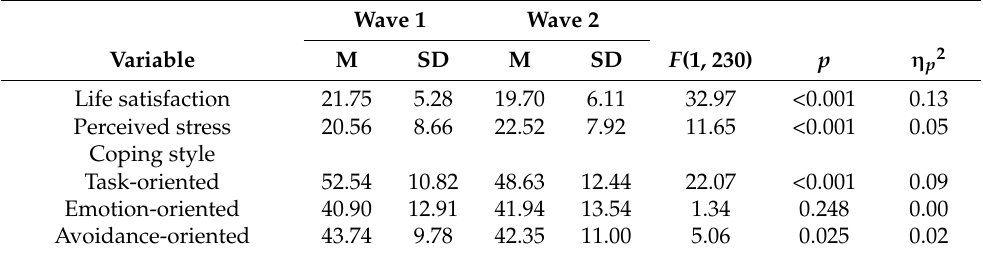
Table 2. Differences in life satisfaction, perceived stress, and coping styles between the first and second waves of the COVID-19